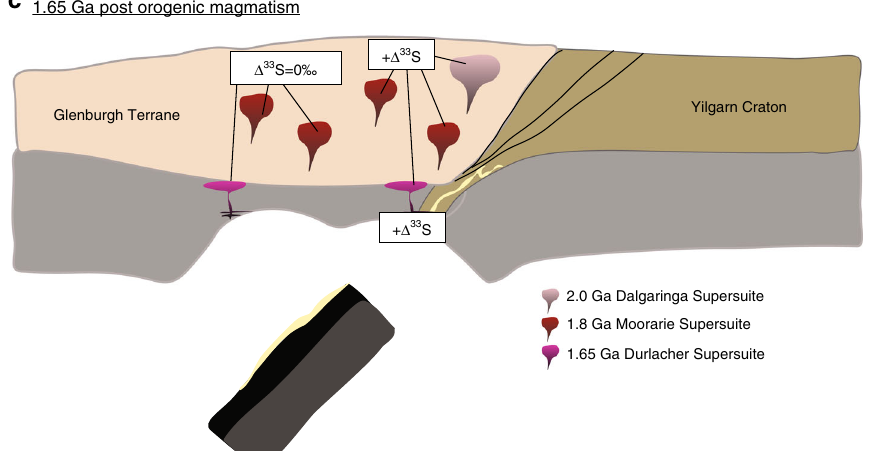
Fig. 5 Model for transfer of sur fi cial sulfur from surface to crystalline crust through time splices. a Deposition of MIF-S-bearing aerosols into the water column some time prior to 2.4 Ga. The positive + Δ 33 S signature is preserved in iron-rich sedimentary rocks outboard of the Yilgarn Craton. b As the Yilgarn Craton collides with (and subducts beneath) the Glenburgh Terrane during ca. 2.0 Ga ocean closure 32 , MIF-S-bearing sedimentary rocks devolatilize and volatiles are transferred (captured as + Δ 33 S) to mantle-derived arc melts. c Post-orogenic magmatism generates MIF-S-bearing plutons close to the margin of the Yilgarn Craton, locally recycling the + Δ 33 S signature from the deep lithospheric MIF-S-bearing reservoir to the ca. 1.8 Ga Moorarie Supersuite (time splice not shown) and the ca. 1.65 Ga Durlacher